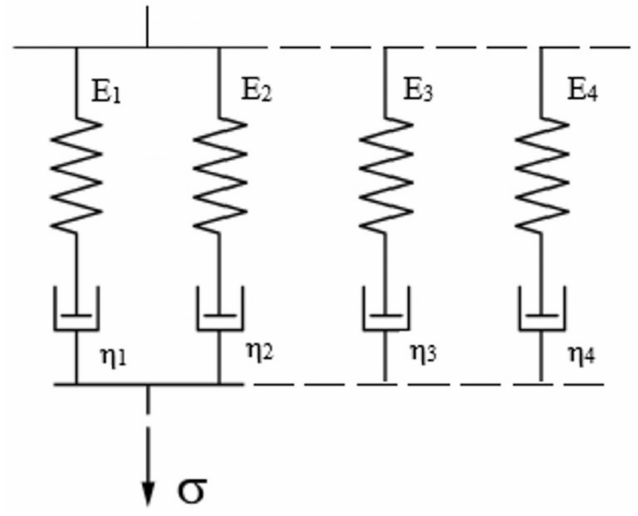
Figure 3. Combination of elastic and viscous elements in generalized Maxwell models with 4, 6 and 8 parameters